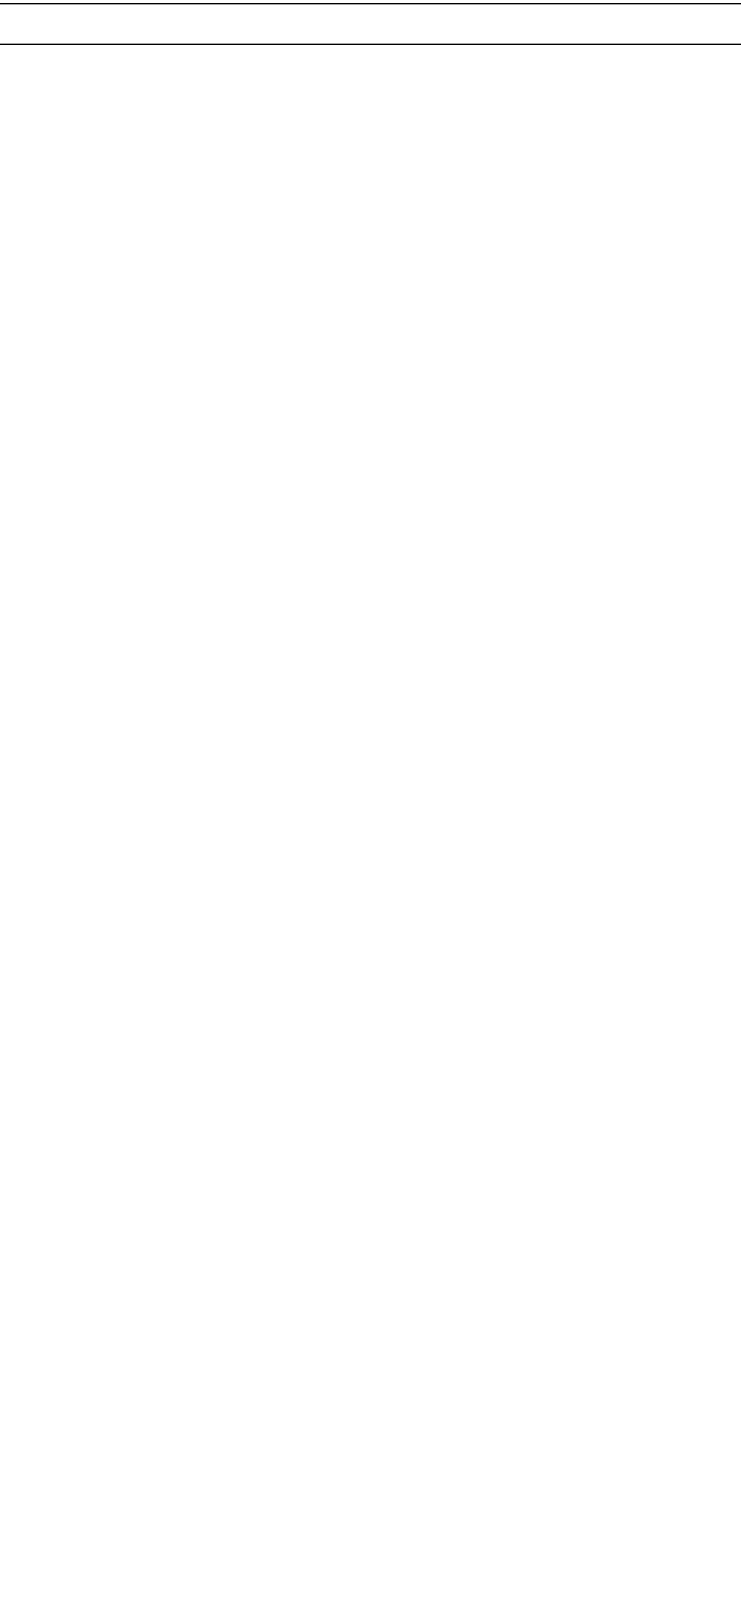
Table 1. Sample characteristics of survey